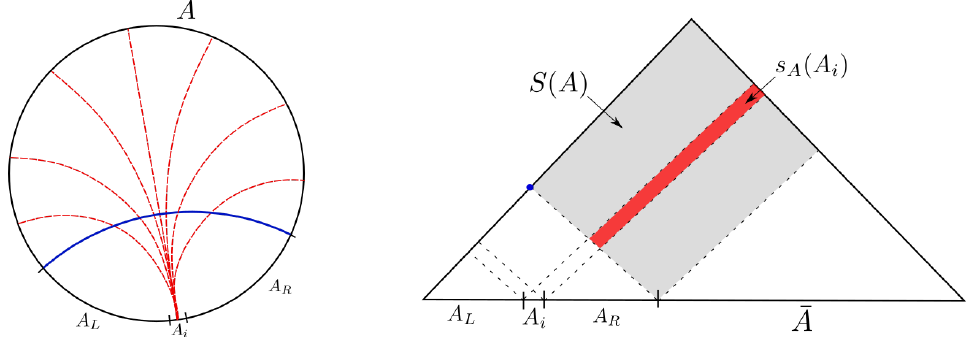
Figure 2: Left: A time slice of an asymptotically AdS geometry. The blue curve is 3 the RT surface of boundary region A , and the red curves are representatives of the set of all geodesics that connect A to ¯ A . Right: Kinematic space, where each point i represents a boundary-anchored geodesic in AdS . The blue dot is the RT surface. 3 The grey region is the set of all geodesics between A and ¯ A , whose volume is S ( A ) . The red region is the set of geodesics between A and ¯ A , whose volume is the CMI i proposal for partial entanglement